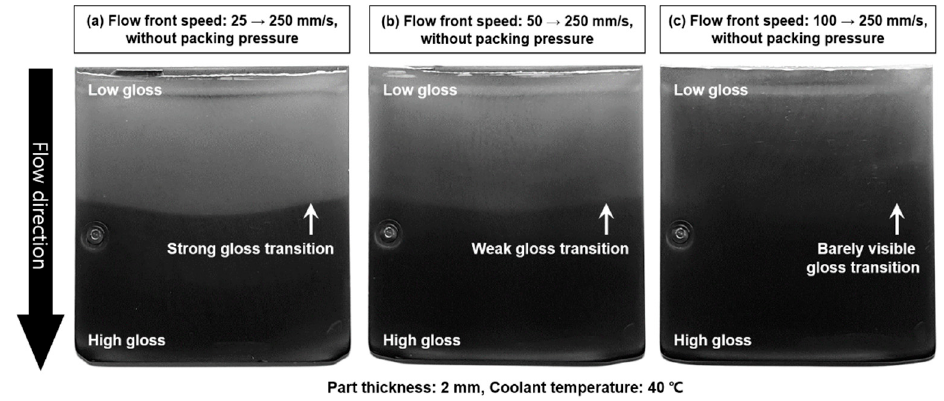
Figure 14. Effect of the flow front speed fluctuation on the gloss transition defect; ( a ) flow front speed fluctuation 25-250 mm/s, ( b ) flow front speed fluctuation 50-250 mm/s, and ( c ) flow front speed fluctuation 100-250 mm/s.